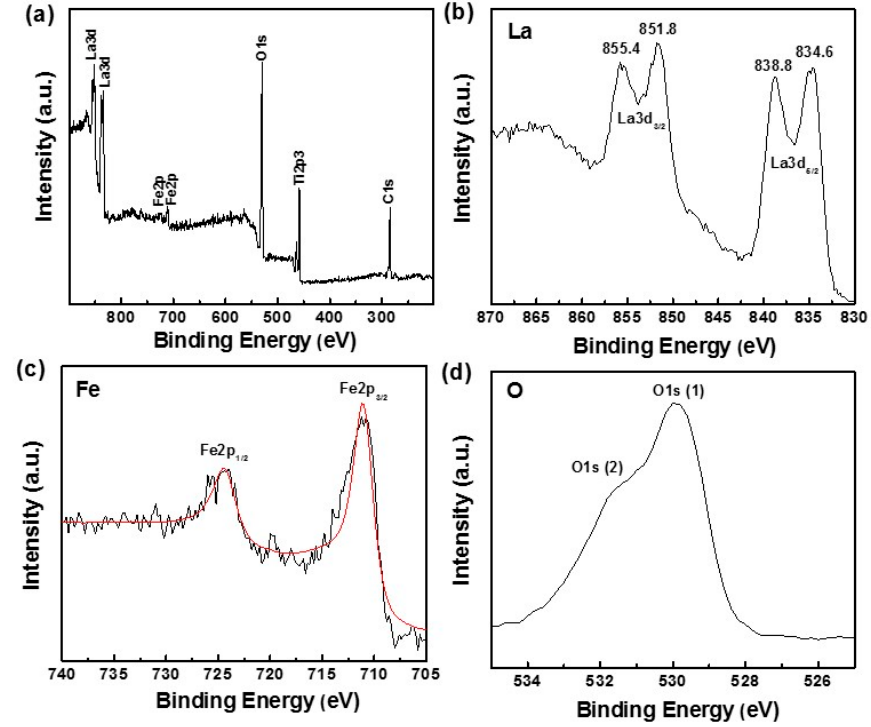
Figure 3. XPS spectra of LaFeO 3 /TiO 2 nanotube arrays: ( a ) a survey XPS spectrum and high resolution spectra of Fe ( b ), La ( c ), and O ( d ).